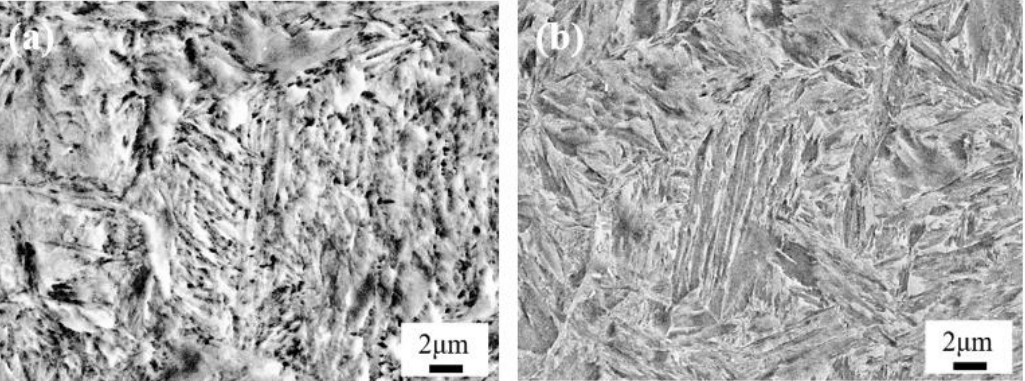
Figure 12. SEM images of the morphology of the carburized layer at a 0.3 mm depth for process 2: ( a ) after the quenching + cryogenic treatment; and ( b ) after the quenching + cryogenic treatment + tempering.